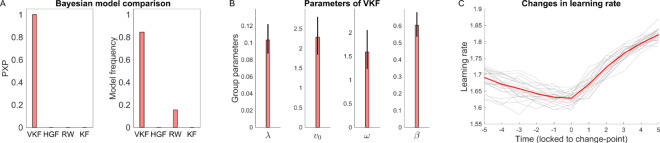
Bayesian analysis of VKF in the first experiment.A) Bayesian model comparison results comparing VKF with HGF, Rescorla-Wagner (RW) and Kalman filter (KF). Protected exceedance probabilities (PXPs) and model frequencies are reported. The PXP of the VKF is indistinguishable from 1 (and from 0 for other models) indicating that VKF is the most likely model at the group level. The model frequency metric indicates the ratio of subjects explained by each model. B) Estimated parameters of the VKF at the group-level. C) Learning rate signals, time-locked to the change points, estimated by the VKF for all participants (gray) and the mean across participants (red). The x-axis indicates trials relative to change points. The error-bars in B are obtained by applying the corresponding transformation function on the group-level error-bars obtained by the HBI [35] and, therefore, are not necessarily symmetric.